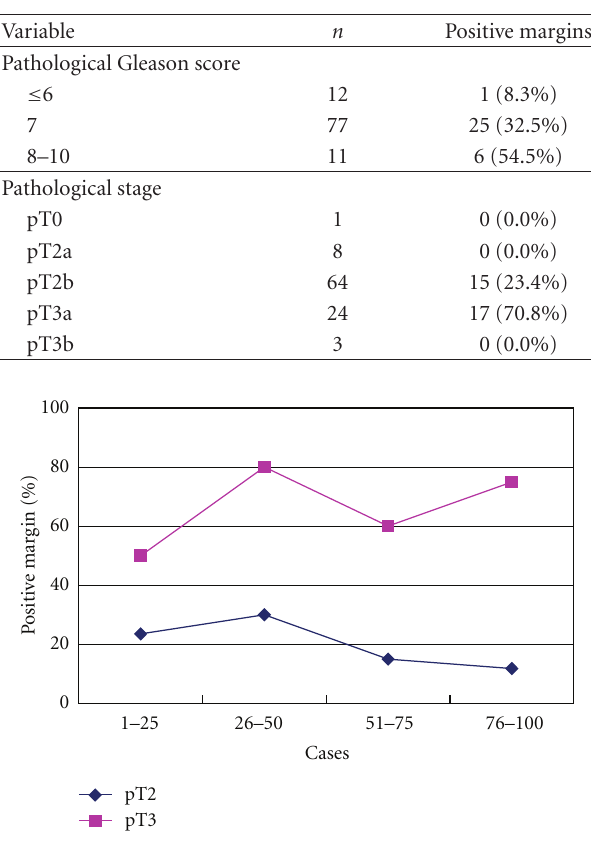
Table 2: Surgical factors for all 100 patients and corresponding percentage of positive margin rates.